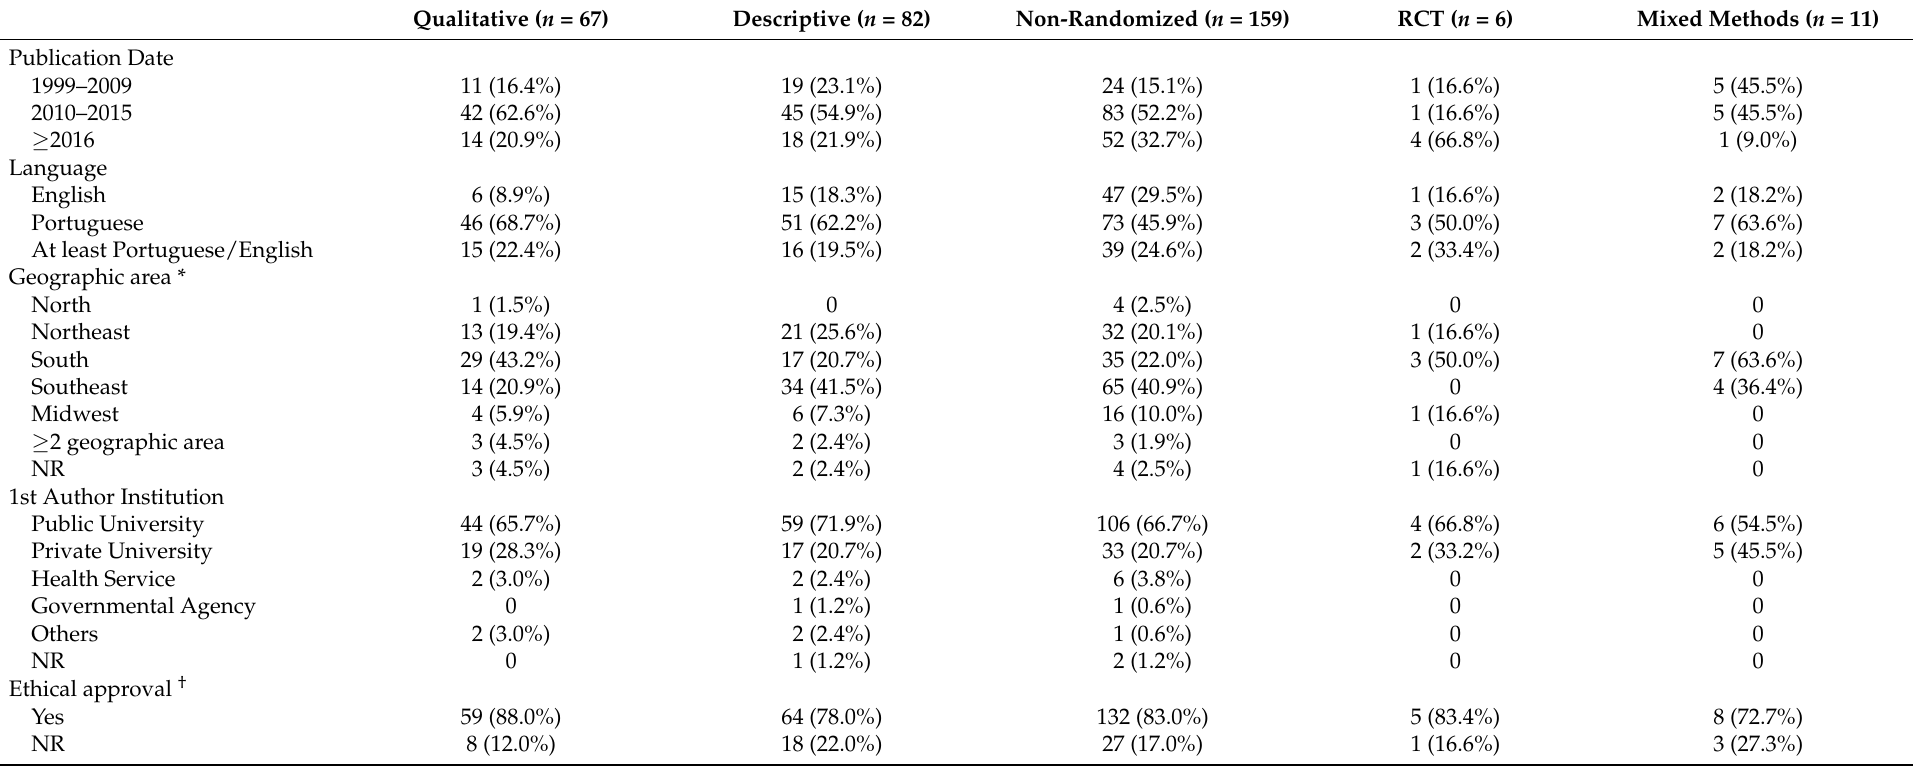
Table 1. Characteristics of included studies regarding primary research conducted in Brazilian long-term care facilities (LTCFs) published in scientific journals by